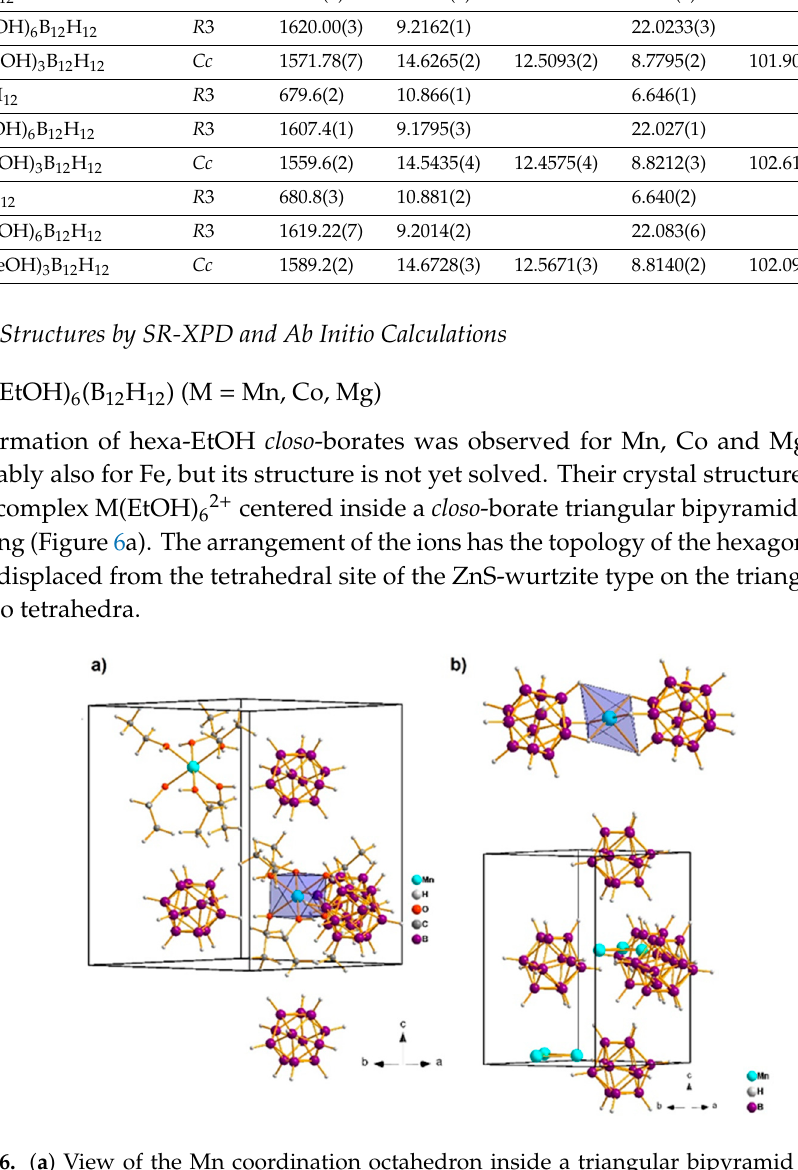
Figure 6. ( a ) View of the Mn coordination octahedron inside a triangular bipyramid (B 12 H 12 ) 5 of hcp anion packing in tg -Mn(EtOH) 6 (B 12 H 12 ) as optimized by density functional theory (DFT). ( b ) Disordered experimental structure of solvent free tg -Mn(B 12 H 12 ). The metal is disordered inside a triangular bipyramid (B 12 H 12 ) 5 of hcp anion packing. DFT optimized local structure with octahedral coordination of Mn is shown